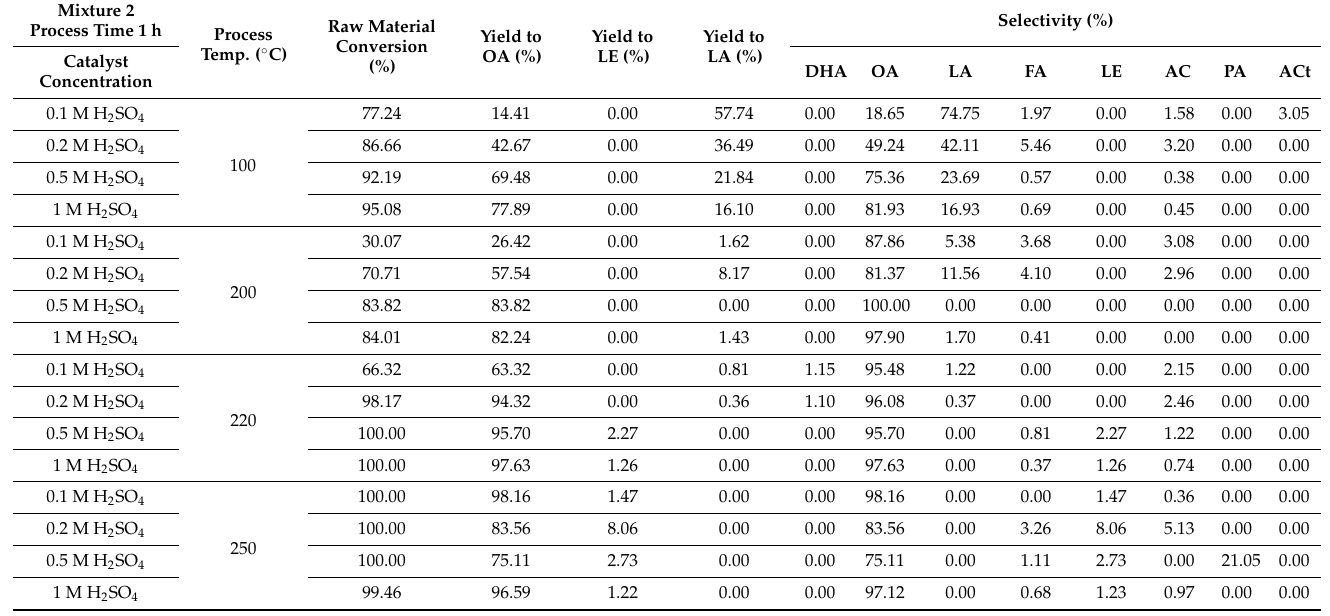
Table 2. The results of HPLC analysis for the catalytic conversion of hemicellulose carbohydrates using the homogeneous H 2 SO 4 catalyst in the liquid phase, with a 1 h process time for mixture 2.